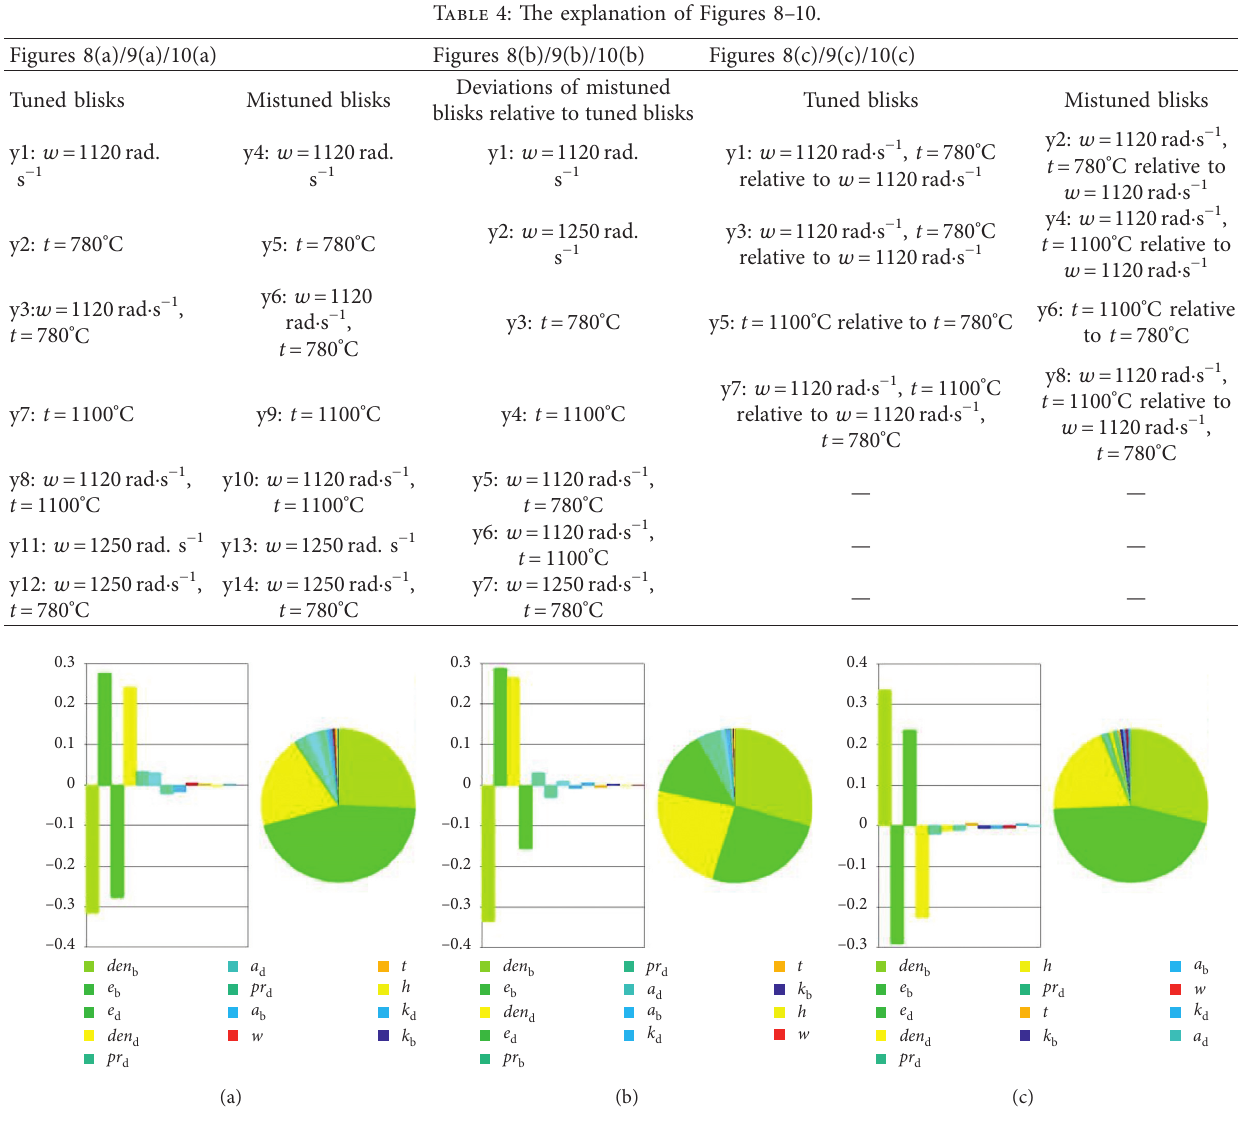
Figure 11: Sensitivity of the modal shape amplitudes for MTB. (a) Sensitivity of DAs. (b) Sensitivity of SAs. (c) Sensitivity of SEAs.